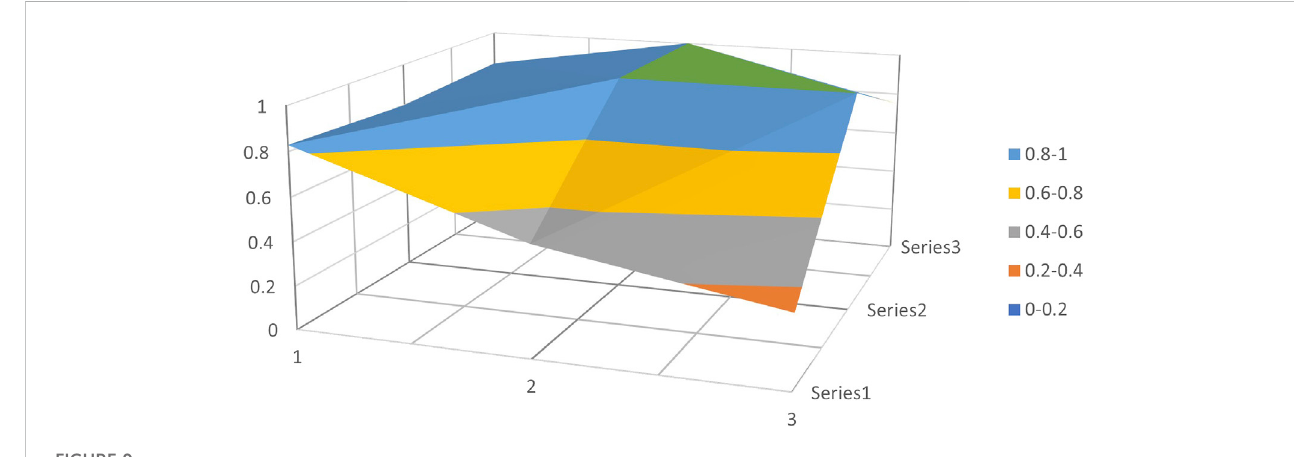
FIGURE 9 PMC surface of P 9